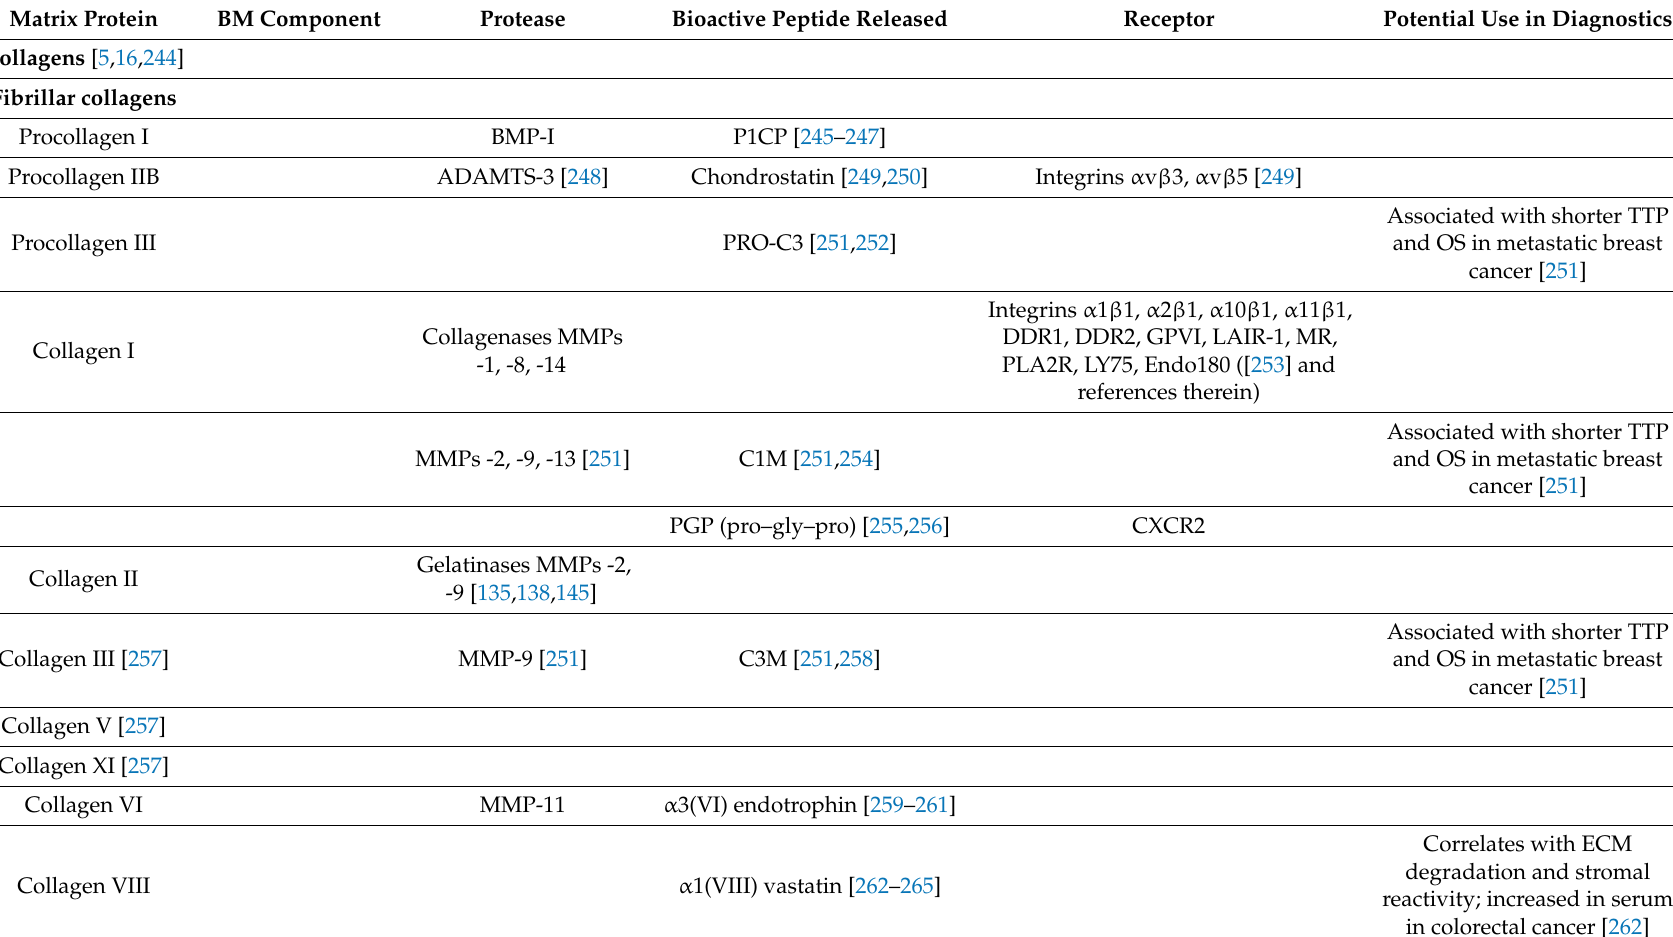
Table 1. Matrix proteins of the TME can release bioactive peptides called matrikines, which regulate tumor progression and metastasis, and can be used